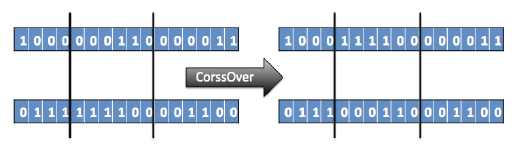
Fig. 3. Crossover operator over two points.